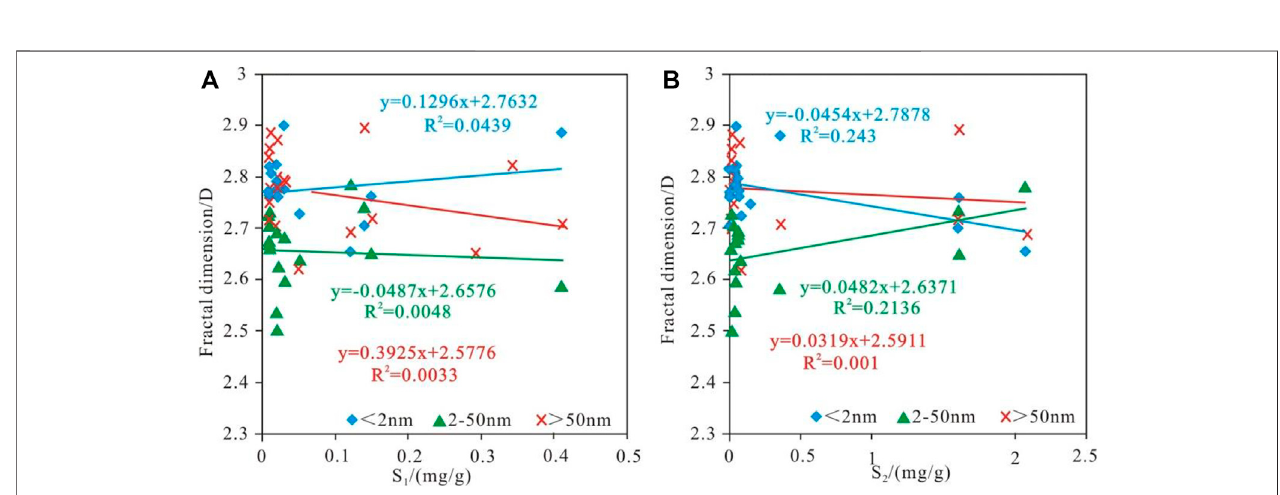
FIGURE 18 | Pore size distributions and relationship between fractal dimension and kerogen. Relationship between fractal dimension and (A) S 1 , (B) S 2 .